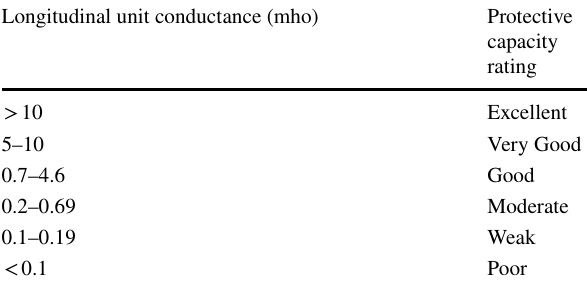
Fig. 20 Layer model interpretation for VES 10 Table 3 Modified longitudinal conductance/protective capacity rating (Oladapo et al. 2004) Longitudinal unit conductance